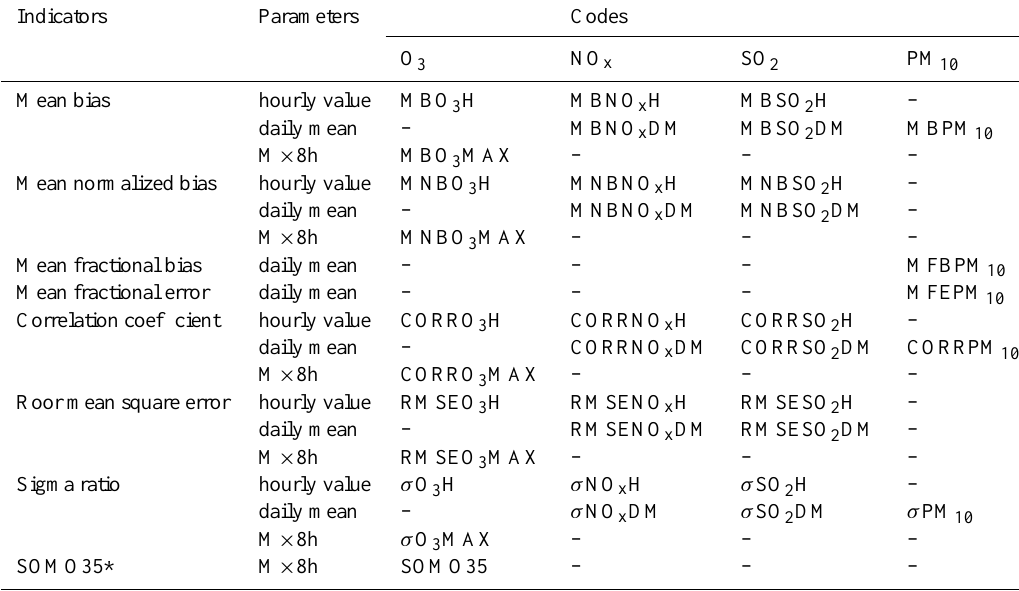
Table 4. Metrics considered in the evaluation of O 3 , NO x , SO 2 and PM 10 concentrations.